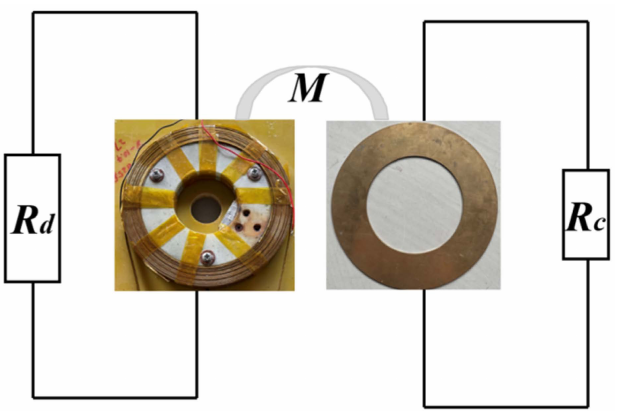
Figure 2. Experimental schematic diagram for discharging tests of the HTS coil.